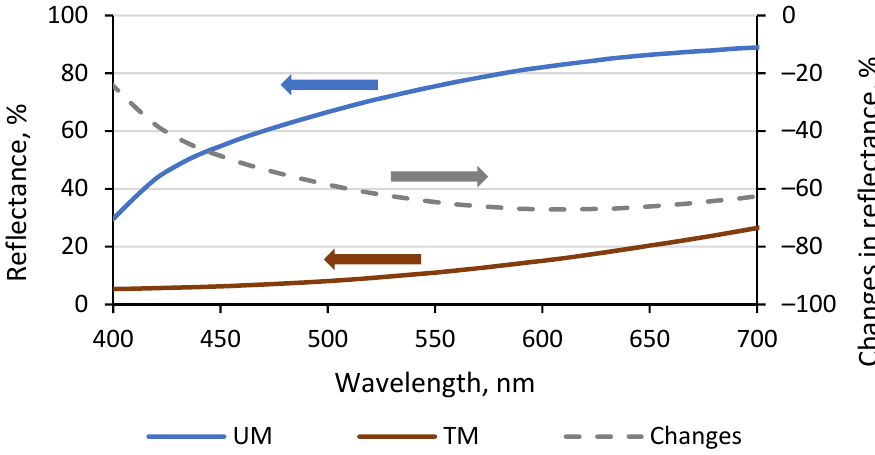
Figure 2. Reflectance spectra of unmodified (UM) and thermally modified (TM) wood. Although the absorption of radiation of definite wavelengths is mandatory for wood photo-discoloration, the absorption of light does not necessarily lead to chemical trans- formations. Moreover, only the chemical changes affecting chromophores result in discol- oration [36]. Therefore, information about spectral sensitivity of the material is important to develop coating formulations providing effective protection, especially when transparent coatings are preferable for the maintenance of wood’s natural appearance. For the identifi- cation of thermally modified wood, spectral sensitivity and evaluating the changes caused by the thermal treatment, both unmodified and thermally modified wood specimens were exposed to direct solar radiation and to solar radiation filtered through glass filters trans- mitting definite wavelength ranges of the solar spectrum. The results of the experiment (Figure 3) clearly demonstrate differences in spectral sensitivity regarding discoloration of the two tested wood